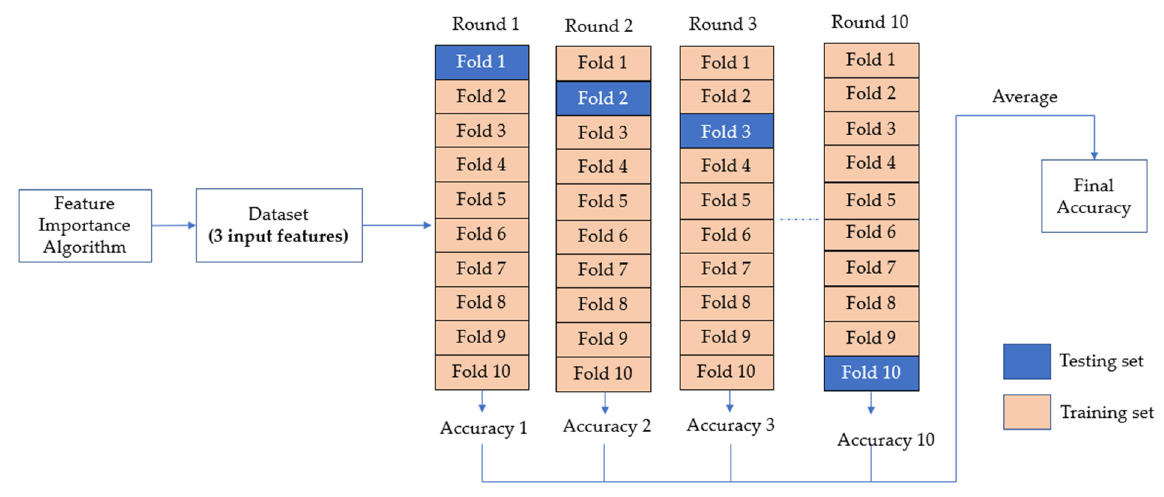
Figure 5. Feature optimization steps.